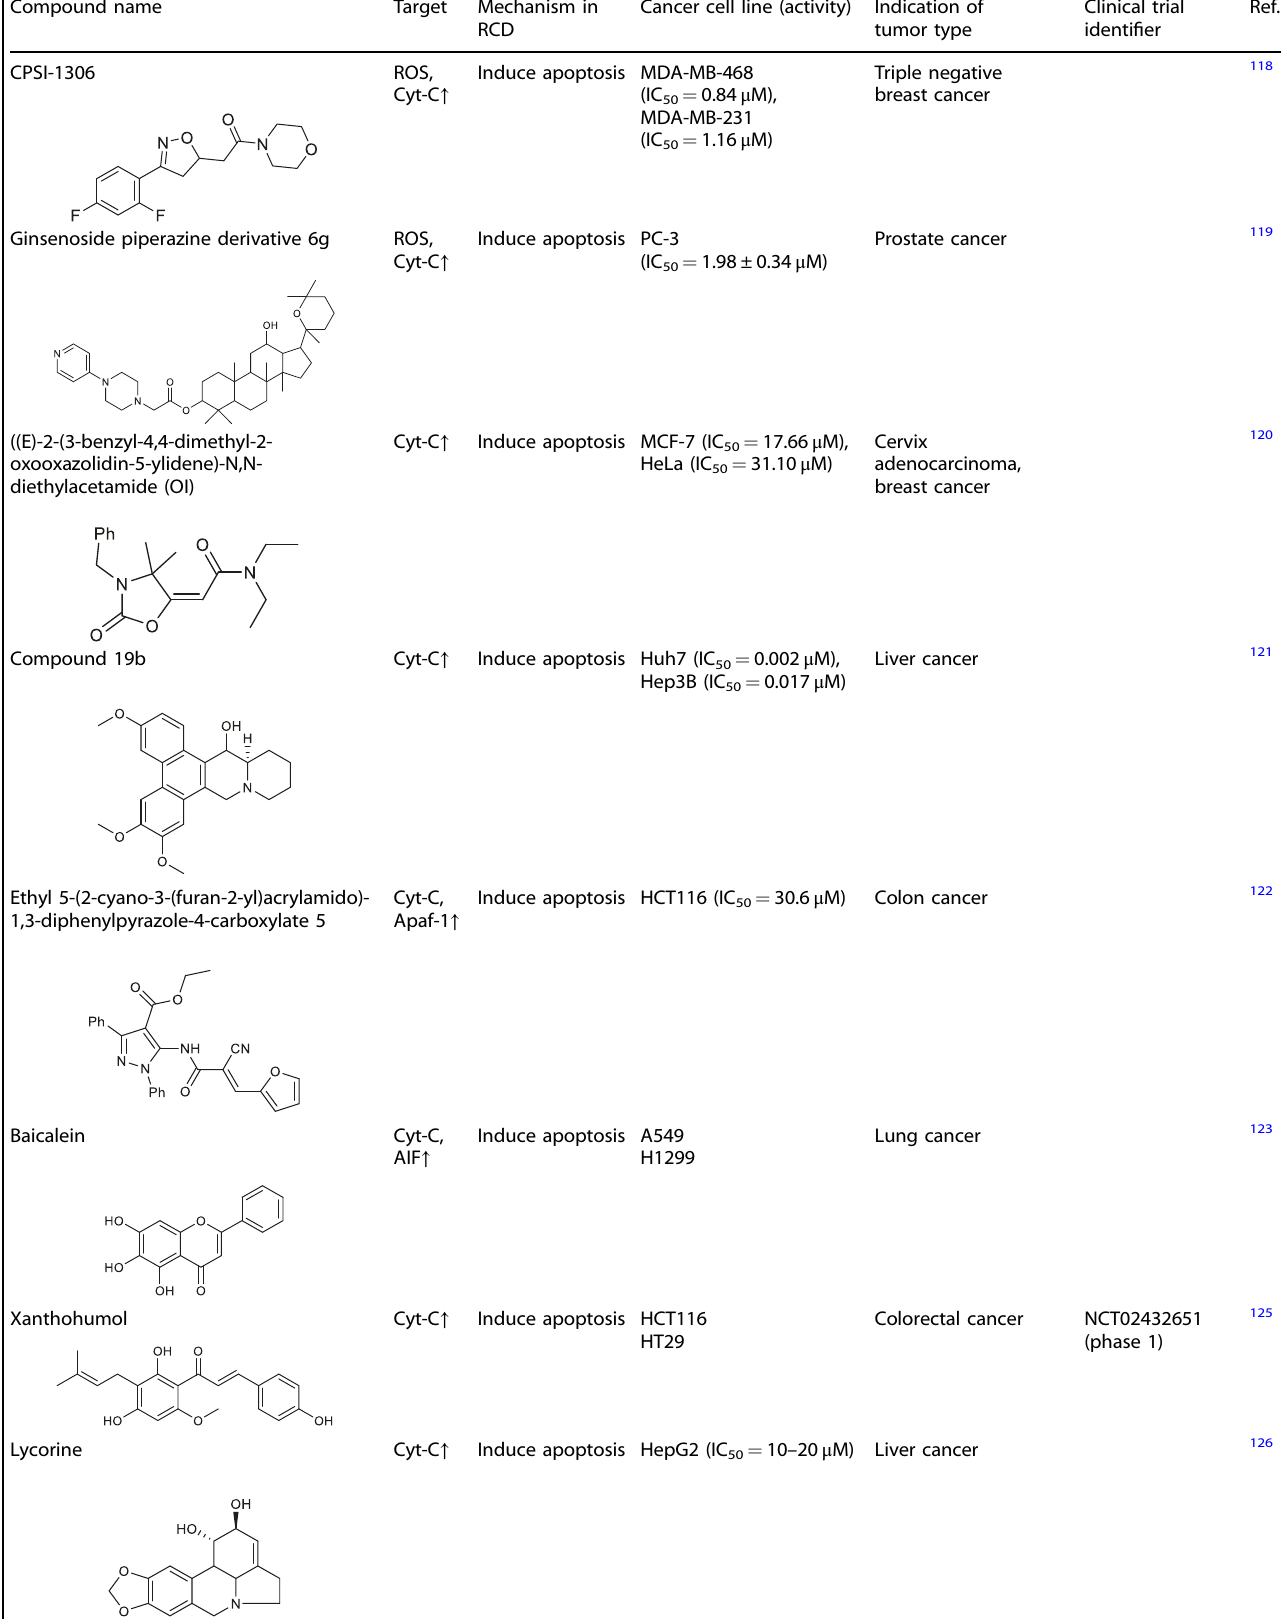
Table 3. Compounds targeting Apaf-1 and Cyt-C in